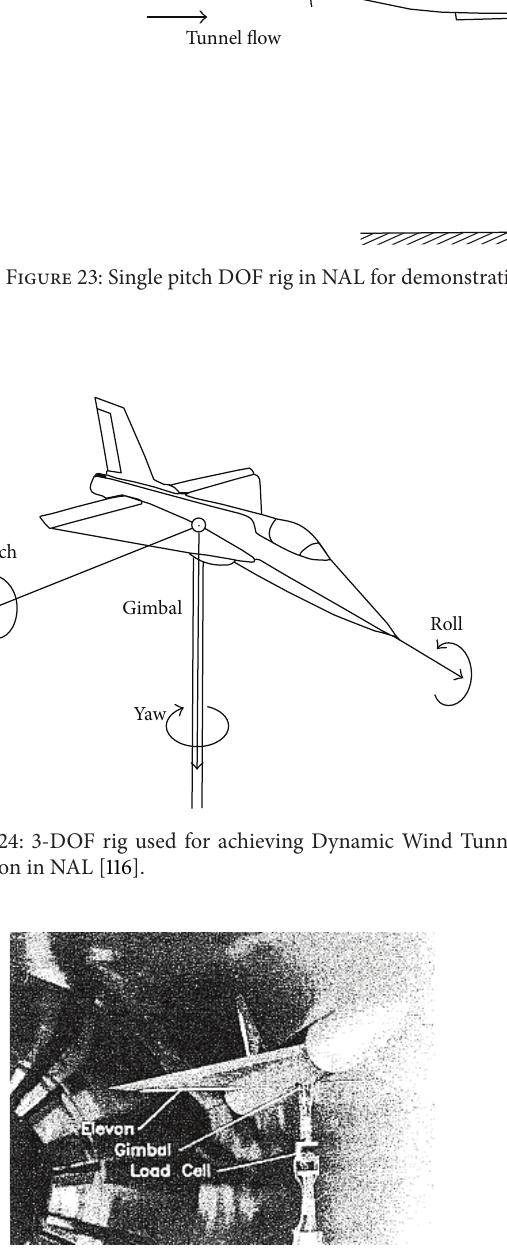
Figure 25: Single pitch DOF rig in NAL for obtaining comprehen- sive longitudinal aerodynamic data [117].